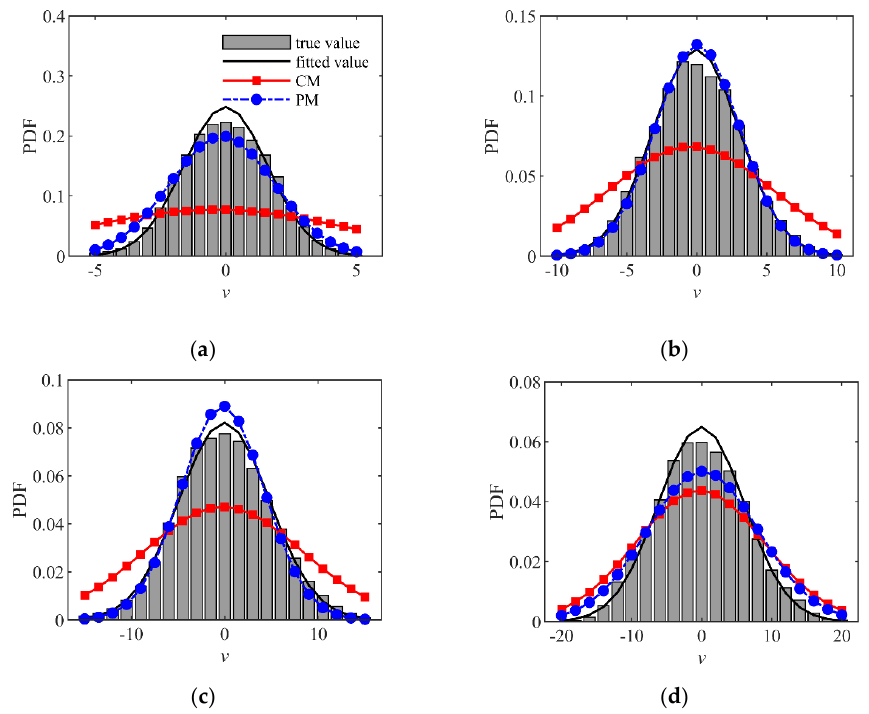
Figure 11. The probability density distribution of spanwise velocity in ( a ) C1, ( b ) C2, ( c ) C3 and ( d ) C4. To summarize, the present method performs well in reporting all parameters with di ff erent conditions. The problems caused by frequency and complex background are resolved by the present